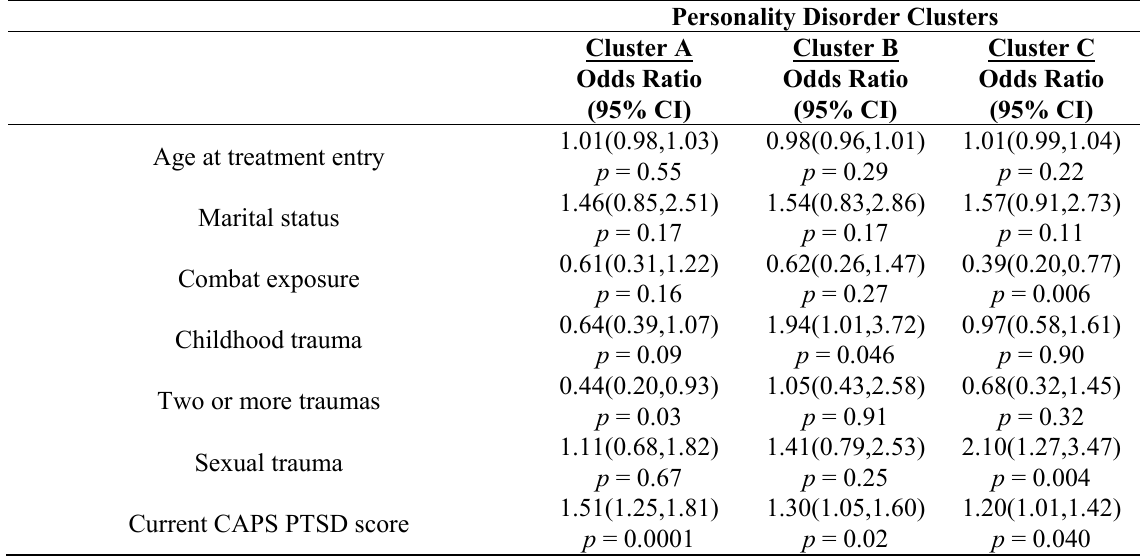
Table 4. Associations among personality disorder clusters and covariates and in a group of women veterans diagnosed with